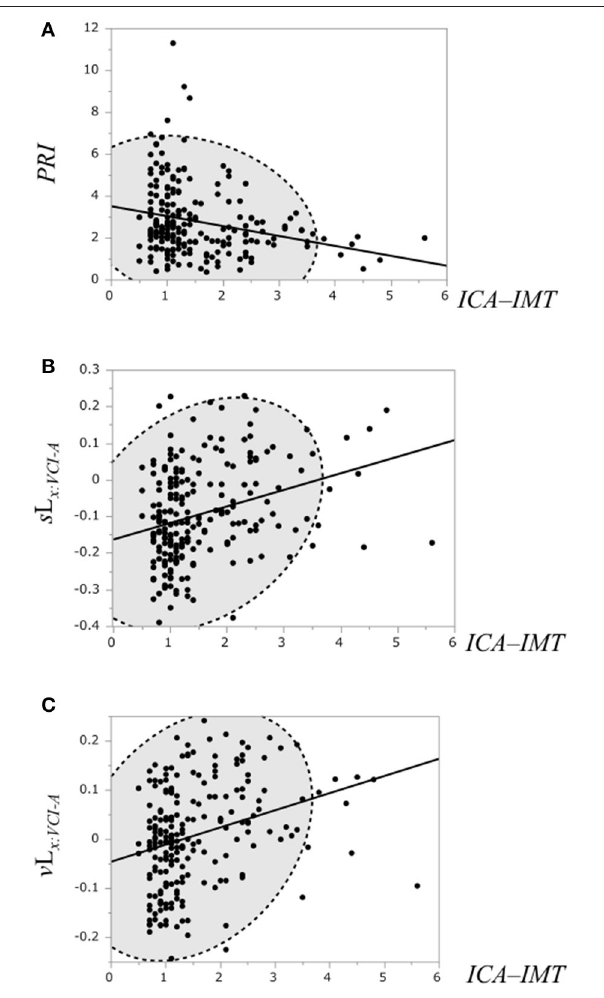
FIGURE 7 | (A) Scatterplot of the PRI and the ICA–IMT. (B) Scatterplot of the binary likelihood s L x : VCI − A and the ICA–IMT. (C) Scatterplot of the binary likelihood v L x : VCI − A and the ICA–IMT. Broken elliptical shape indicates a 95% confidence ellipse for normally distributed